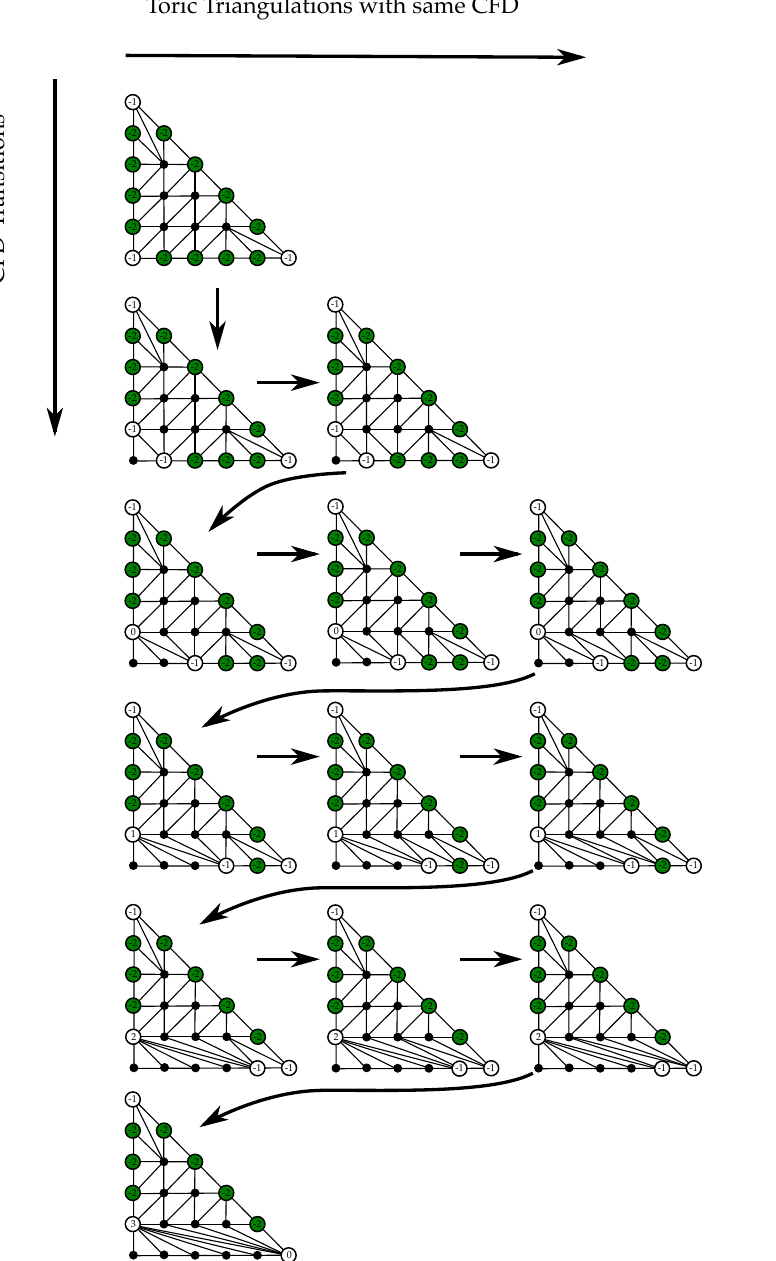
Figure 9 . CFD-transitions versus Flop Transitions for T 5 : the vertical axis corresponds to CFD- transitions, which act on the CFD-vertices (out vertices in the toric diagram) only. Not every toric (cid:13)op corresponds to a CFD-transition: each horizontal line corresponds to the same CFD, but a di(cid:11)erent toric triangulation. The arrows show how the (cid:13)ops connect various (cid:13)op phases.